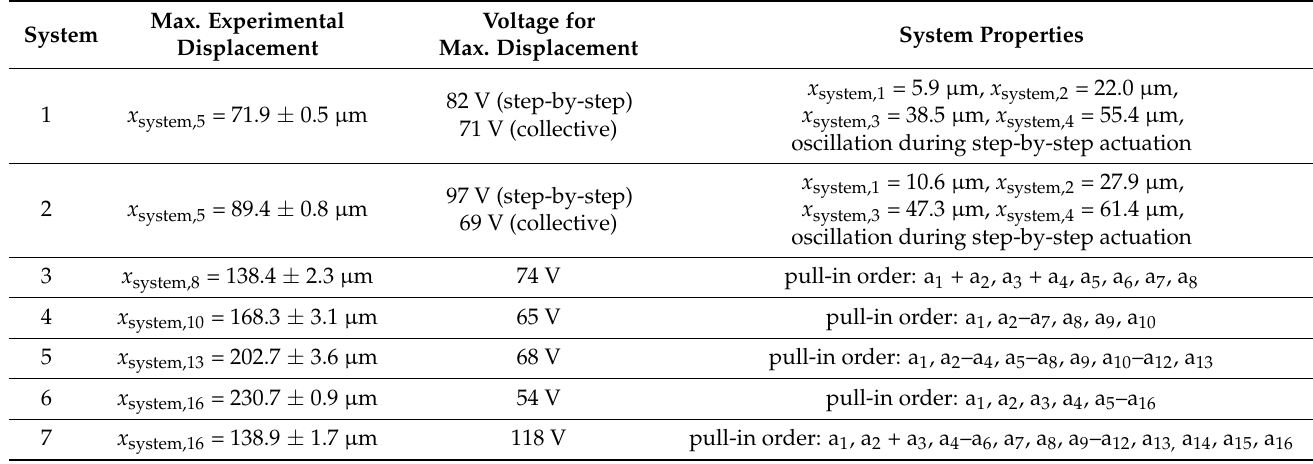
Table 2. Overview of the experimental results that will be discussed in the following chapters.